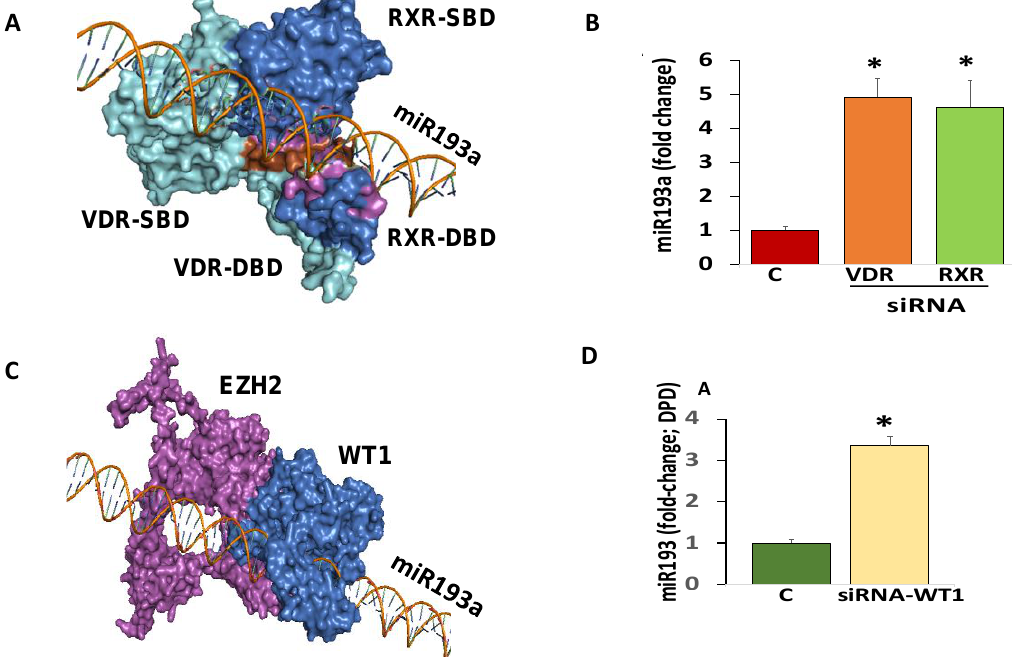
Figure 4. Determination of repressors contributing to the downing of miR193a expression. ( A ) Vitamin D receptor- Retinoid X receptor (VDR-RXR) heterodimer-miR193a complex. DNA binding domain (DBD) of RXR (Marine blue) and substrate-binding domain (SBD) of RXR (Marine blue) are involved in binding with DNA (miR193a). Some interacting residues of RXR-DBD and RXR-SBD are represented in Magenta color, and VDR-DBD and VDR-SBD are represented in Brown color. VDR substrate-binding domain (SBD) and DNA binding domain (DBD) is represented in Cyan color. ( B ) DPDs were transfected with either siRNA-VDR or siRNA-RXR (n = 3). After 48 h, RNAs were extracted from control (C) and siRNA-VDR- and siRNA-RXR-transfected DPDs. RNAs were assayed for miR193a. Cumulative data from three independent experiments are shown in bar graphs. * p < 0.05 compared with control (C). ( C ). WT1 recruits EZH2 and binds at miR193a promoter. WT1 (Marine blue) binds on miR193a promoter with interacting residues (Magenta). ( D ). DPDs were treated with bu ff er or transfected with siRNA-WT1 (n = 3). After 48 h, RNAs were extracted from control (C) and siRNA-WT1-transfected DPDs. RNAs were assayed for miR193a. Cumulative data from three independent experiments are shown in a bar diagram. * p < 0.05 compared with control (C).